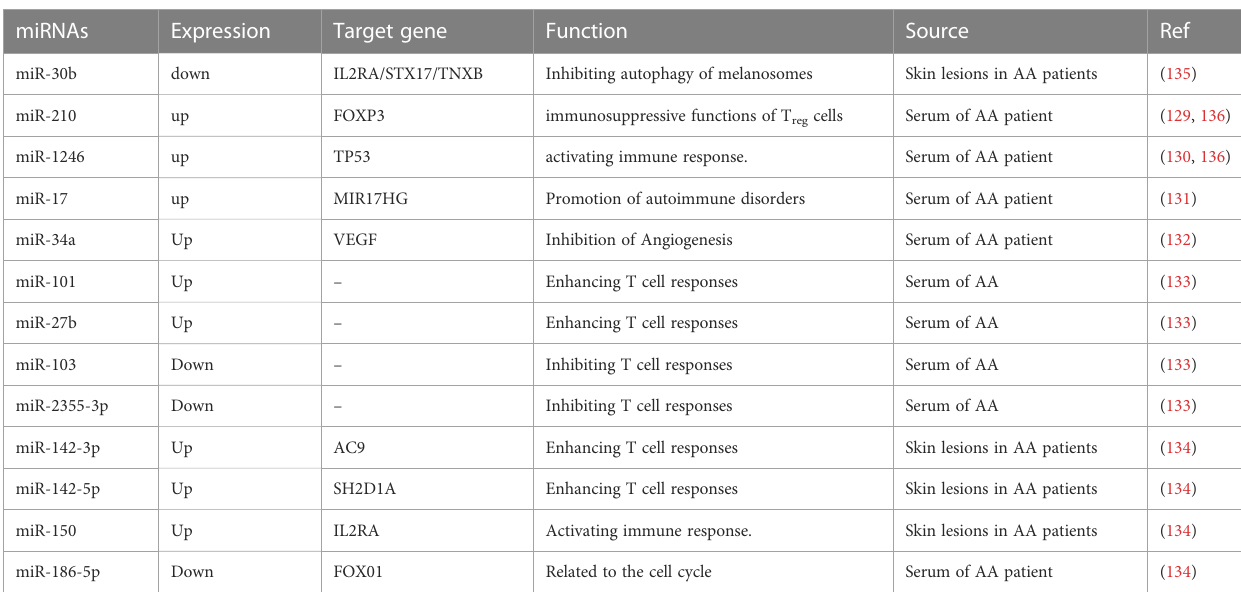
TABLE 1 Functional characterization of the miRNAs in AA